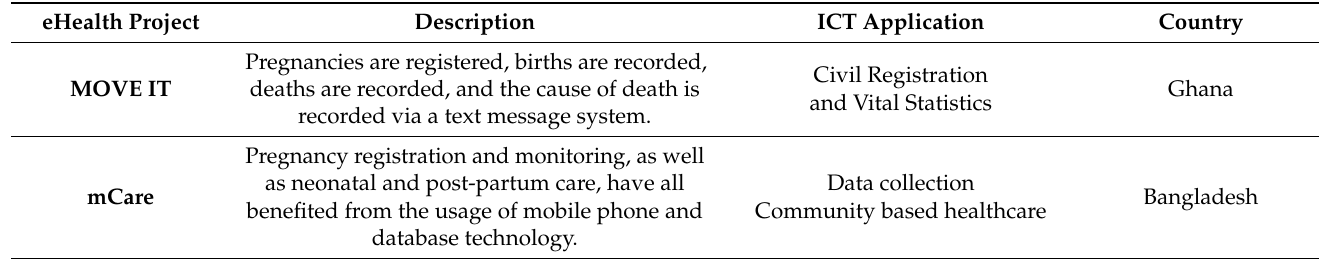
Table 1. Compendium of eHealth projects in selected developing